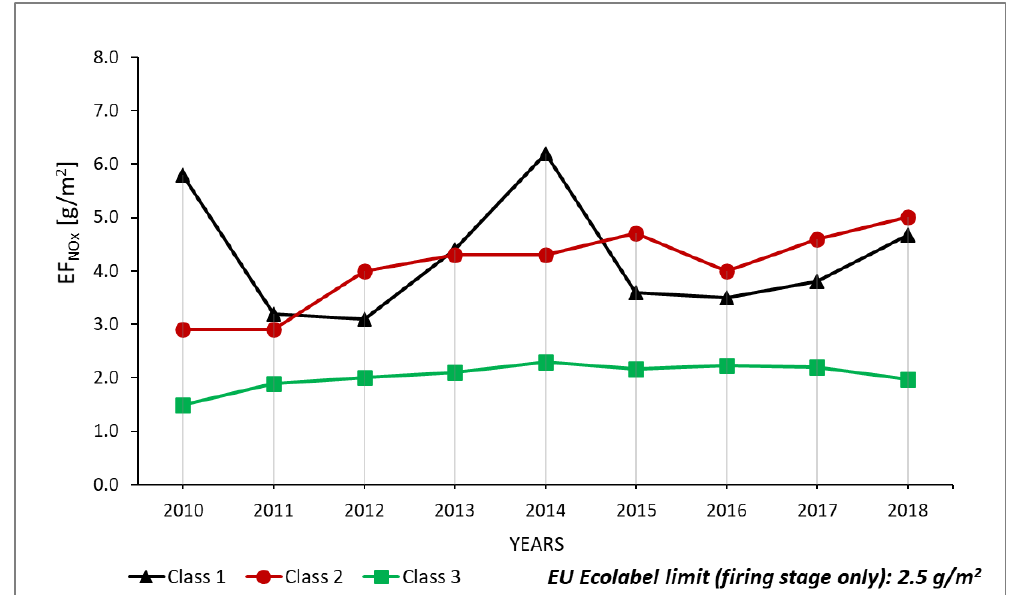
Figure 7. Emission trend for the emission factors for NO x (EF NOx ).